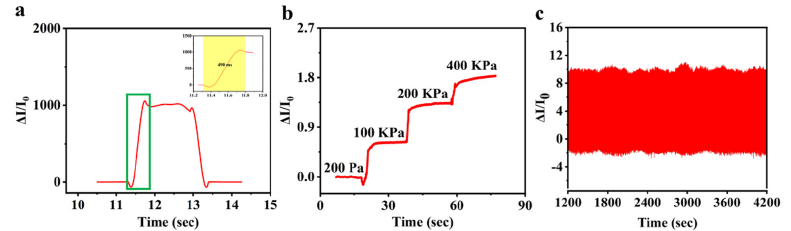
Figure 7. Sensing performance test of SF/Gr sensor. ( a ) The I-T curve represents the response time of the SF/Gr sensor about 490 ms. ( b ) The I-T curve shows the relative current variation trend of the SF/Gr sensor under increasing pressure. ( c ) The SF/Gr sensor maintained excellent stability after 2000 cycles of compression tests at 43.1 KPa.